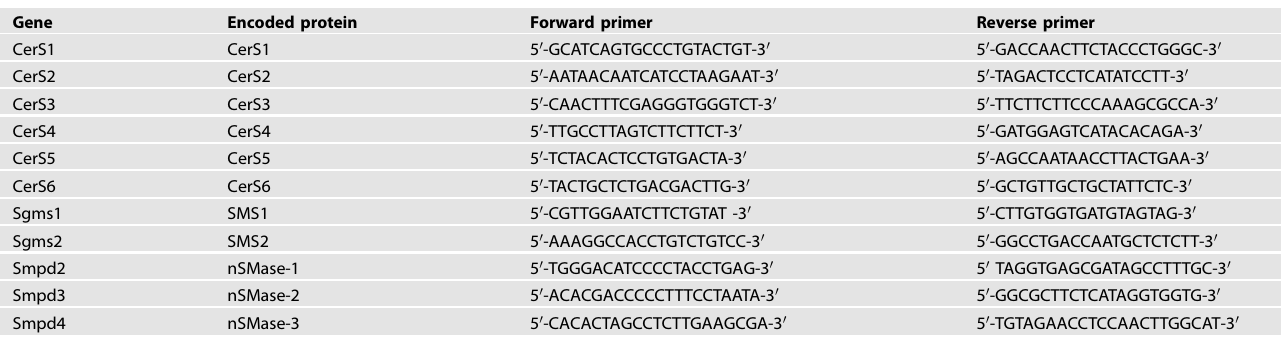
Table 1. Primers used in the qPCR experiments.